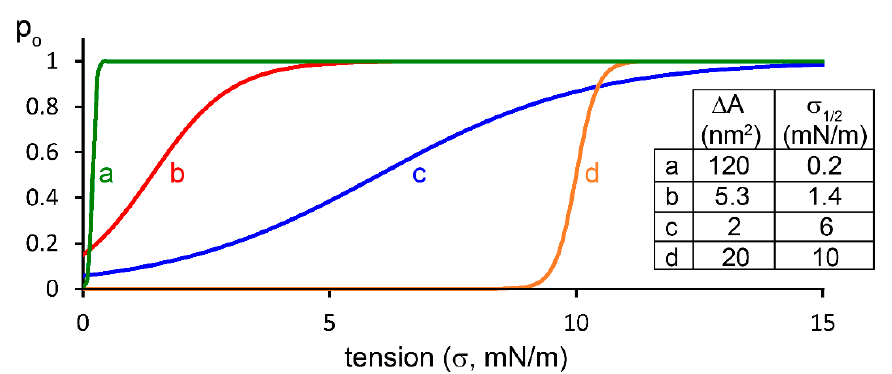
Figure 3. Theoretical mechanosensitivity curves were calculated on the basis of the simple thermodynamic model, considering the change in membrane surface area by channel gating. (a) The theoretical maximum of the change of membrane surface area by Piezo1 gating from structure determinations ( Δ A = 120 nm 2 , [76]) was used with an arbitrary value of σ 1/2 in the resting tension range of the plasma membrane. (b) Δ A and σ 1/2 values of Piezo1 measured by the pressure controlled patch clamp method were applied [72]. (c) The Δ A estimated for TREK-1 and TRAAK channels by the pressure controlled patch clamp [63] was used with a plausible (arbitrary) value of σ 1/2 . (d) The values accepted for the MscL bacterial mechanosensitive channel were used [69,75].